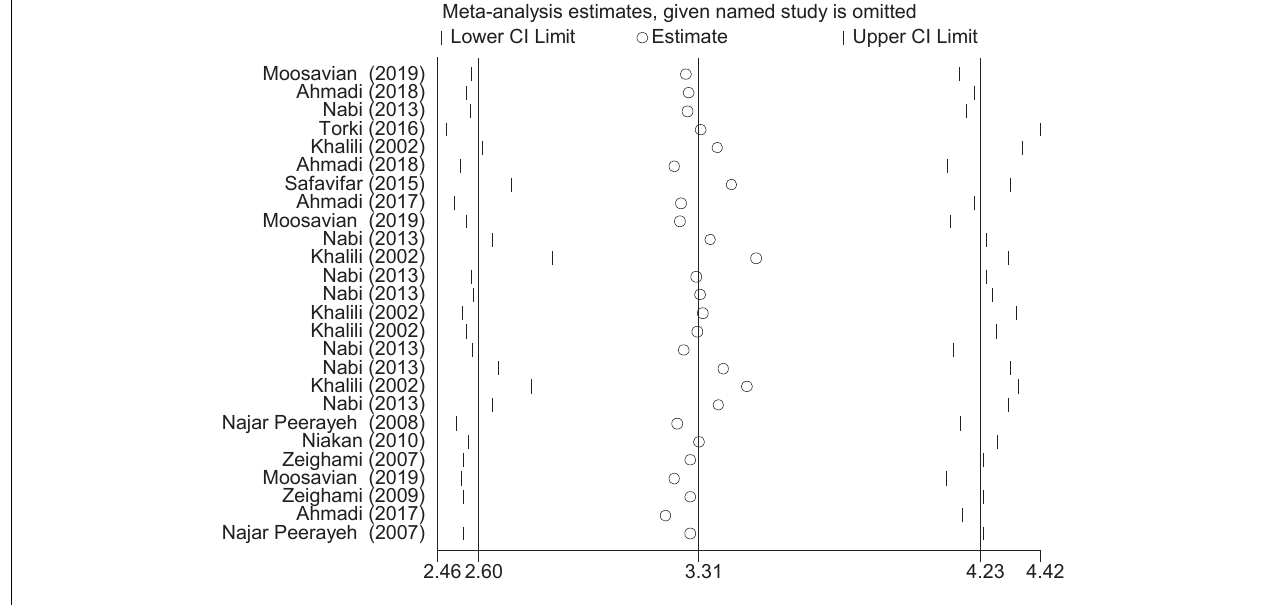
(HCMV), cytomegalovirus (CMV), and human